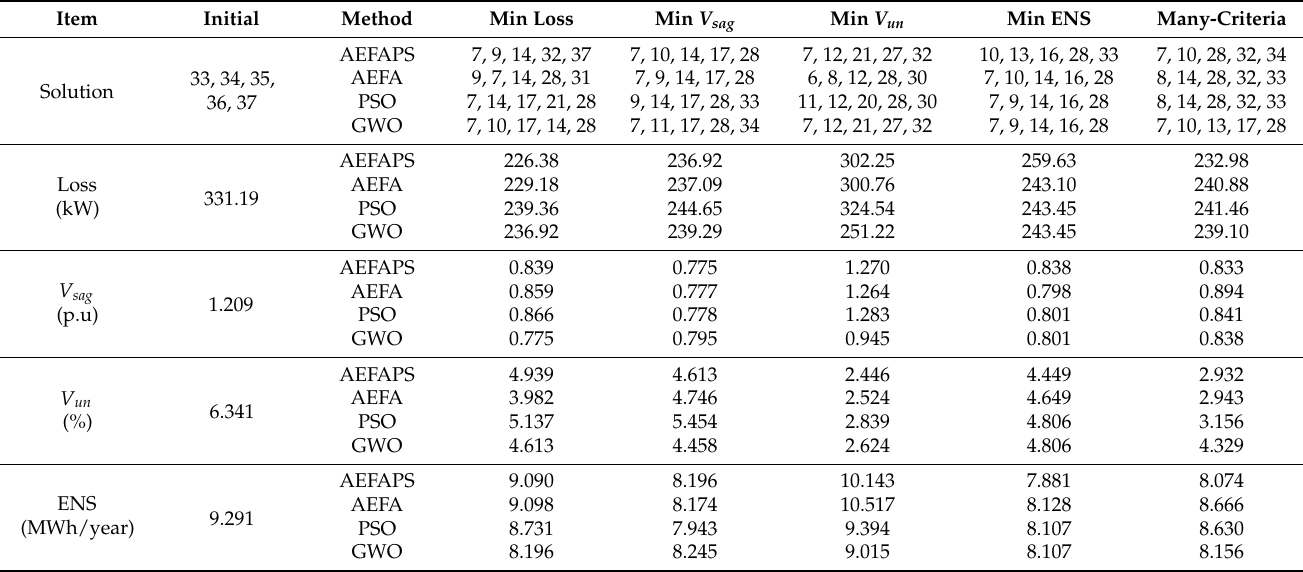
Table 4. Simulation results of single-criterion and many-criteria reconfiguration of an unbalanced 33-bus network (125% of network nominal